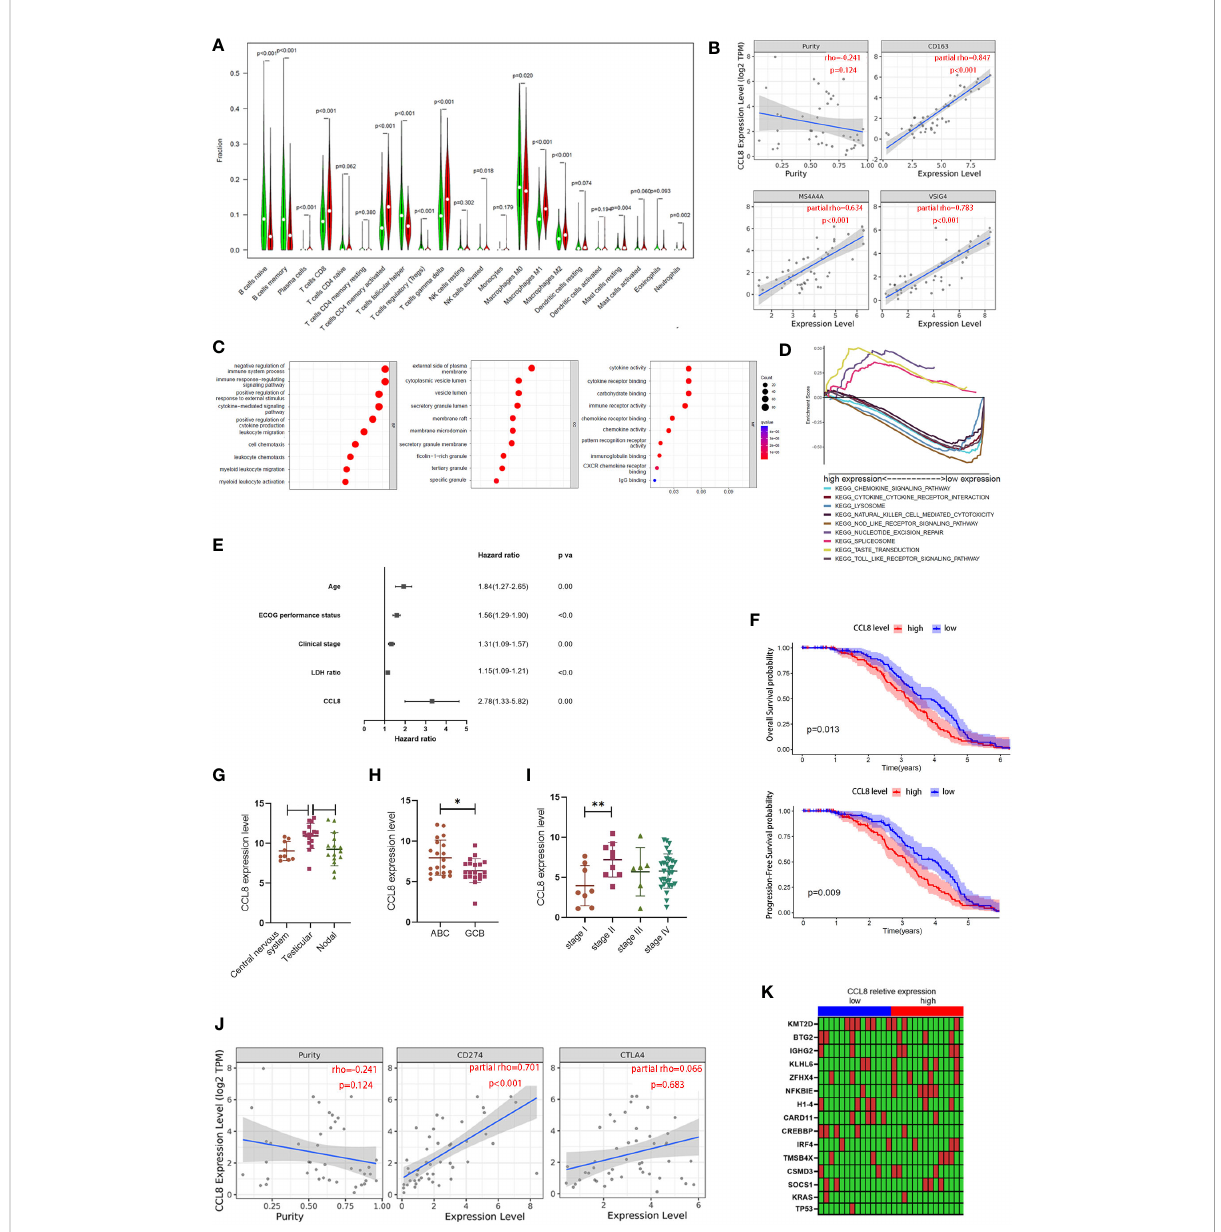
FIGURE 7 Association between CCL8 expression, M2 macrophage proportion, and clinical features. (A) The ratio differences of 21 kinds of immune cells between DLBCL samples with low or high CCL8 expression in TCGA and GEO databases. Statistical test was the Wilcoxon test. (B) The correlation between CCL8 expression and M2 macrophage cell markers in DLBCL via the TIMER website. Statistical test was the Spearman rank correlation test. (C) Bubble plot for GO enrichment of CCL8-related DEGs. Statistical test was the nonparametric test (the x-axis represents the gene, and the y-axis represents the description of the pathway; the circled area is proportional to the number of genes assigned to the term, and the color corresponds to the adjusted P-value; CC: cellular components; BP: biological process; MF: molecular function). (D) Multiple GSEA was used to annotate the KEGG pathway for CCL8-related DEGs. (E) Forest plot showing the hazard ratios of the clinical features and the CCL8 expression level to the overall survival bene fi ts in GSE10846. (F) Kaplan – Meier curves validating OS and PFS in GSE136971. (G – I) Relevance between CCL8 expression and clinical features in GEO datasets (GSE10524, GSE64555, and GSE114175). Statistical tests were Mann – Whitney U tests and ANOVA tests. (J) Relationships between CCL8 expression and immune checkpoints in DLBCL. Statistical test was Spearman rank correlation test. (K) Heatmap of the relationship between mutant genes and CCL8 expression. Statistical test was the Mann – Whitney U test. *P<0.05,